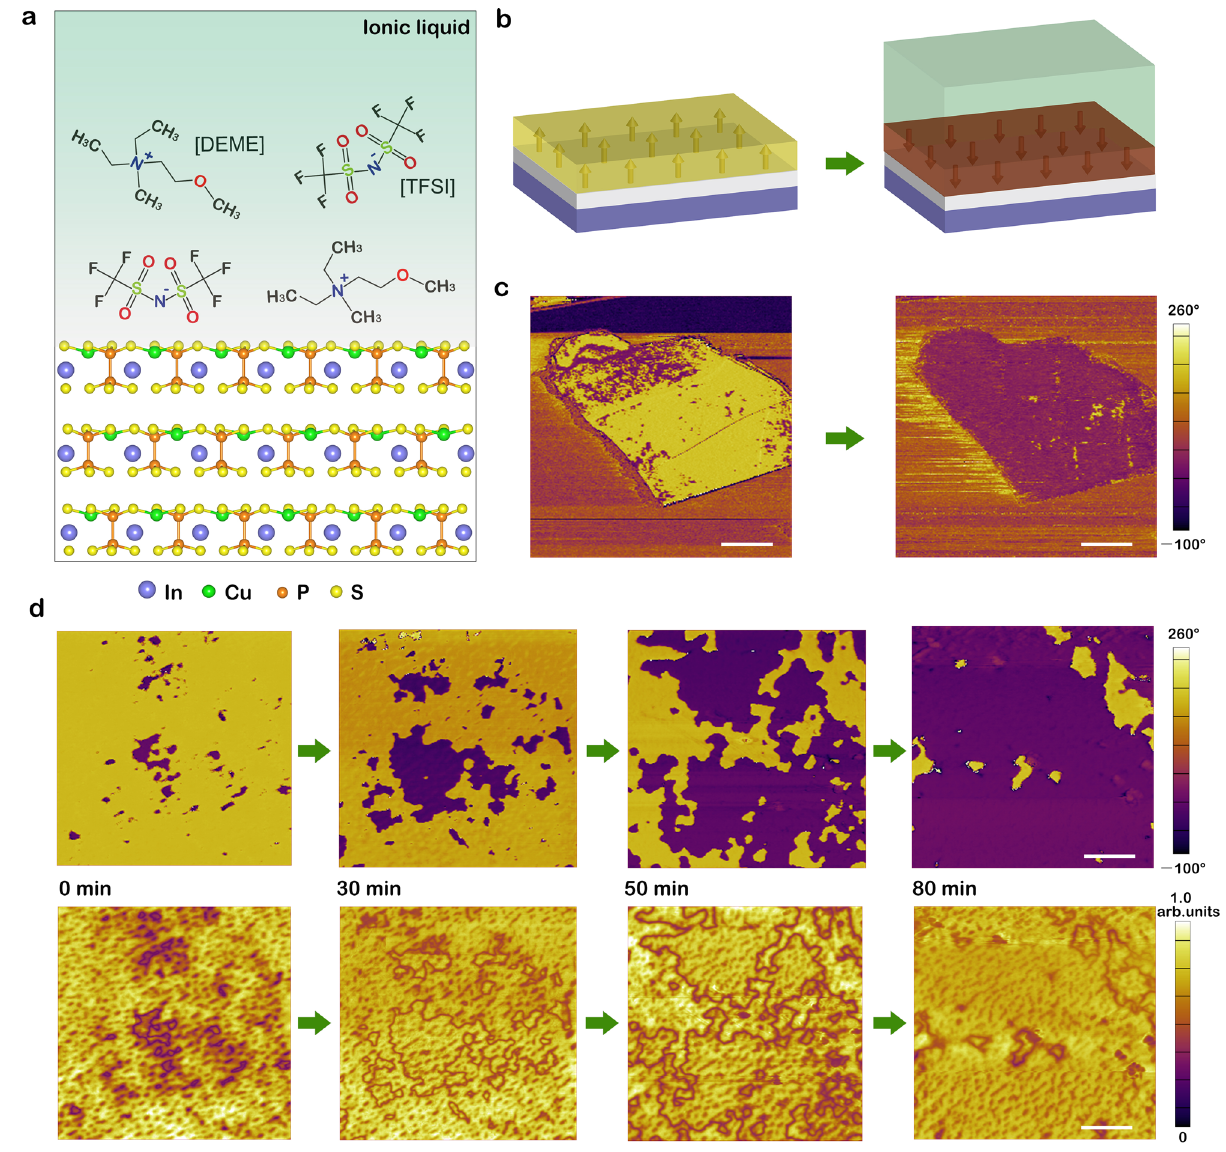
Fig. 1 Ferroelectric domain switching of vdW layered CIPS induced by the ionic liquid. a Sketch of the layered ferroelectric – ionic liquid interface, highlighting the atomic-level structure of CIPS and the molecular structure of ionic liquid [DEME][TFSI]. b, c Schematic diagrams ( b ) and corresponding PFM phase images ( c ) of exfoliated CIPS fl akes on an ultra- fl at Pt/SiO 2 substrate, showing polarization switching from upward (yellow) to downward (purple) polarization state induced by ionic liquid [DEME][TFSI]. The arrows represent ferroelectric dipoles of CIPS. Scale bar in ( c ), 1.5 μ m. d Time evolution of PFM phase (top panel) and corresponding amplitude signals (bottom panel) for a 94 nm-thick fl ake. Scale bar in ( d ), 1 μ